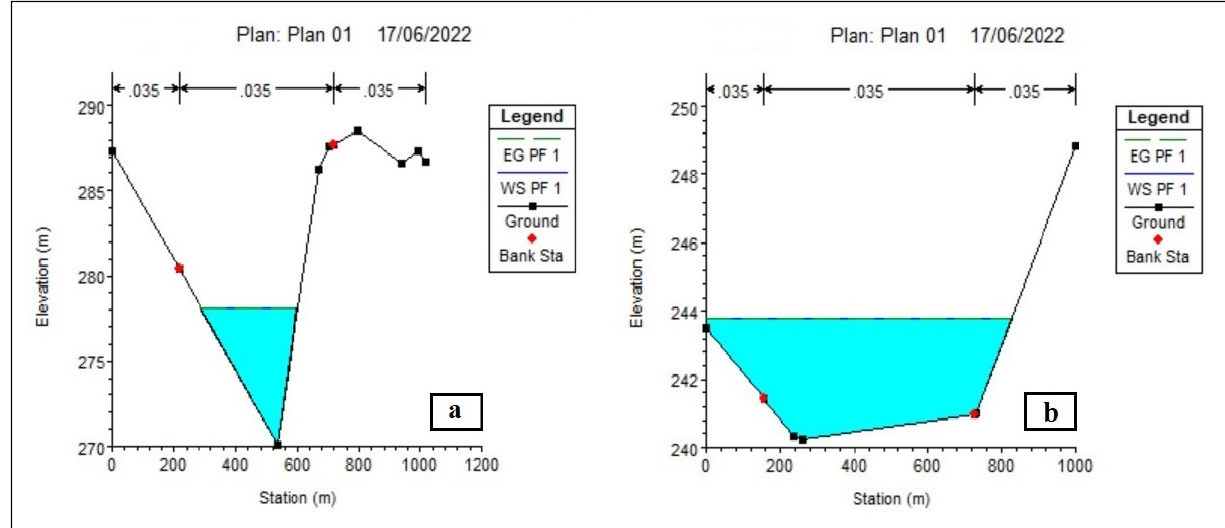
Figure 11. River cross sections for 2013 ( a ) upstream and ( b ) downstream.